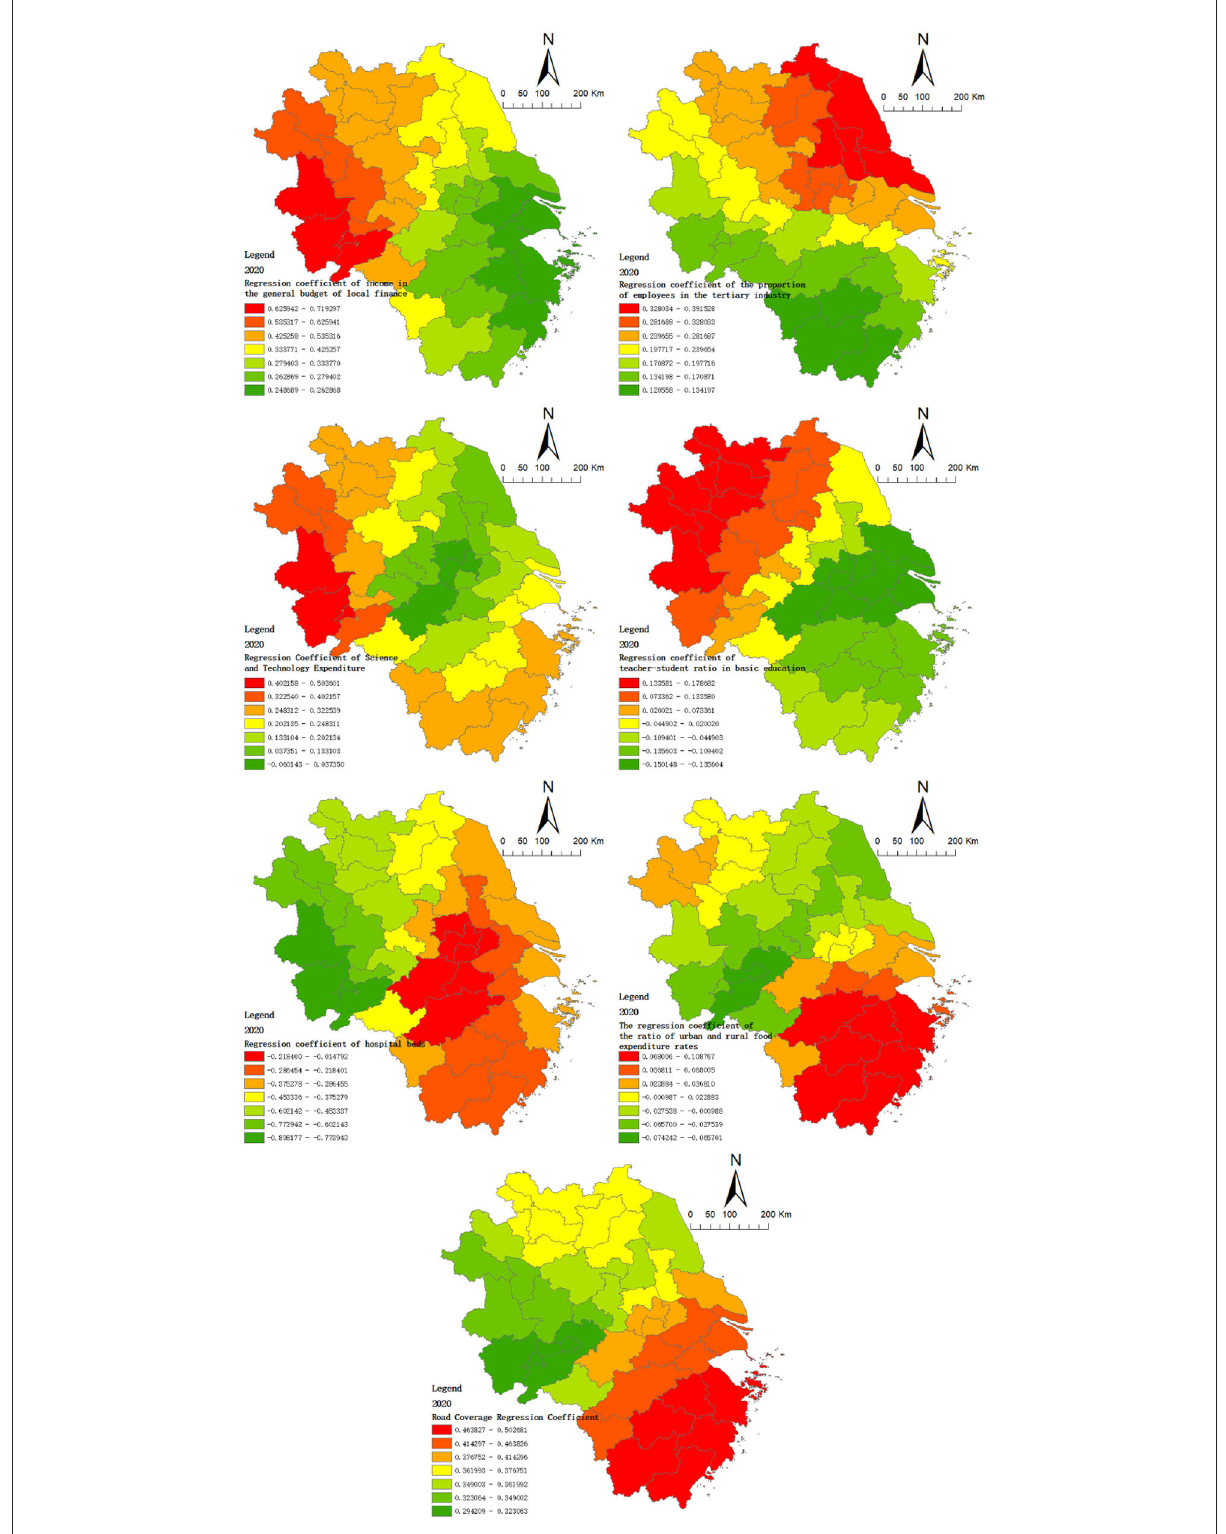
FIGURE5 Spatial distribution of GWR regression coefficients in 41 cities of Yangtze River